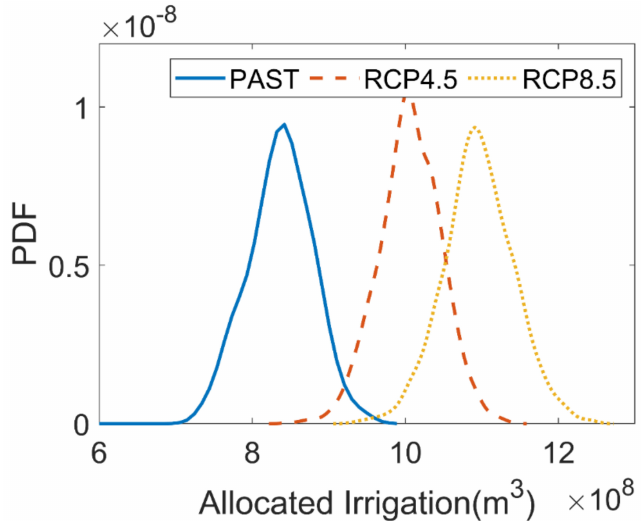
Figure 6. The annual amount of allocated irrigation water under 3 different scenarios.